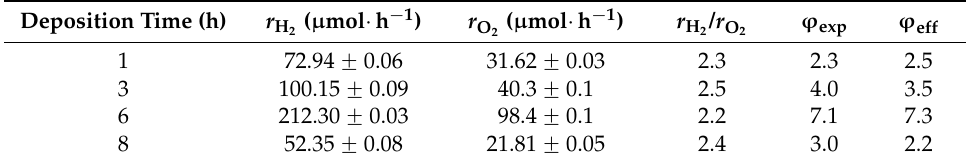
Table 2. Effect of the deposition time on the photocatalytic performance of water splitting.